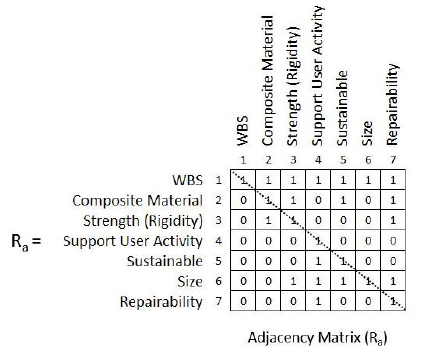
Figure 27. Interpretive Structural Modeling (ISM) Adjacency Matrix.